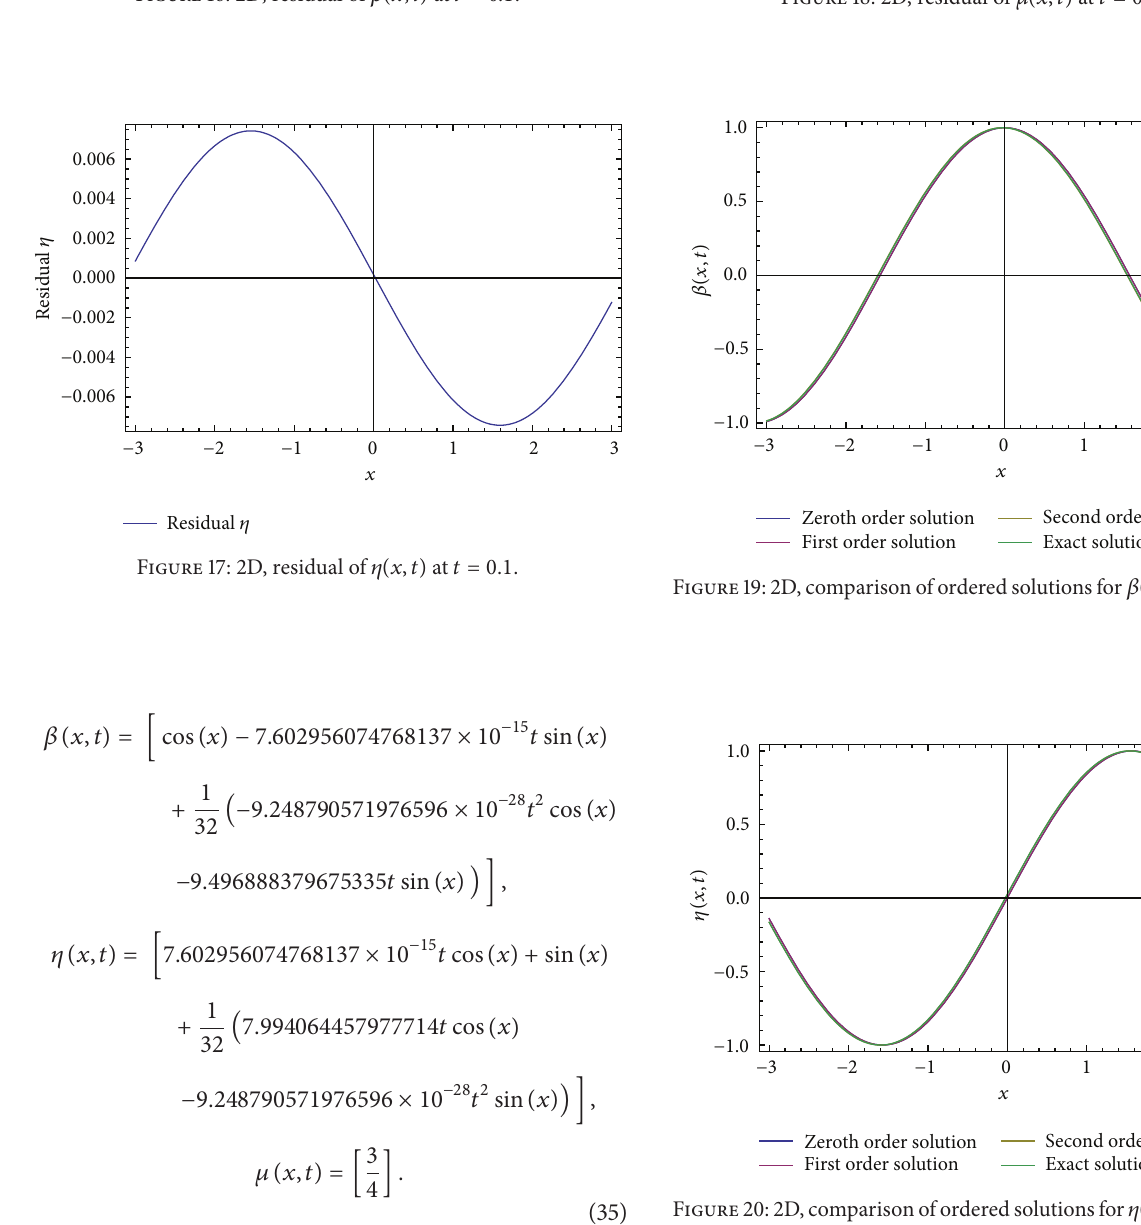
Figure 18: 2D, residual of 𝜇(𝑥,𝑡) at 𝑡 = 0.1 .